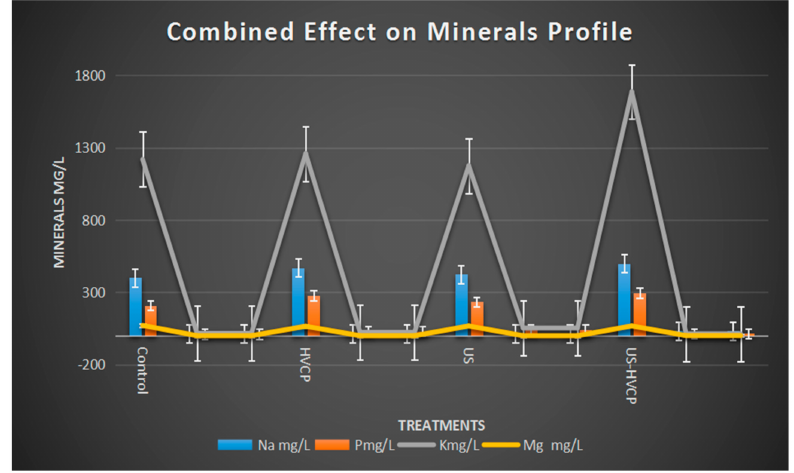
Figure 2. Combined treatment e ff ect of US and HVCP on the mineral profile of the carrot juice. 3.5. Combined Treatment E ff ect of HVCP and US on Physico-Chemical